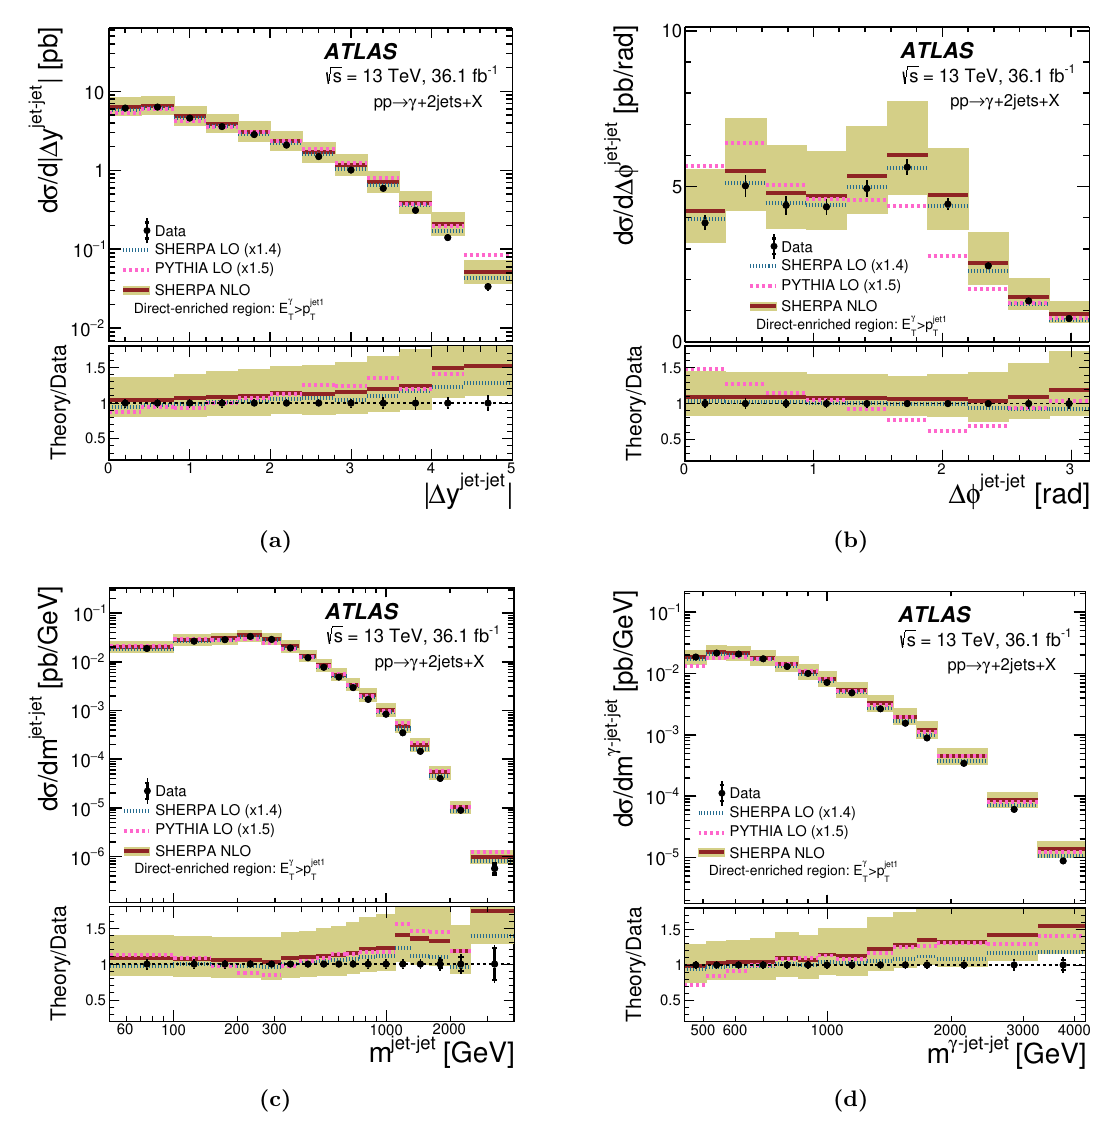
Figure 9 . Measured cross sections for isolated-photon plus two-jet production (dots) as functions of (a) j (cid:1) y jet{jet j , (b) (cid:1) (cid:30) jet{jet , (c) m jet{jet and (d) m (cid:13) {jet{jet for the direct-enriched phase space. The NLO QCD predictions from Sherpa (solid lines) based on the NNPDF3.0 PDFs are also shown. The tree-level plus parton-shower predictions from LO Sherpa (dotted lines) and Pythia (dashed lines) normalised to the integrated measured cross section (using the factors indicated in parentheses) are also shown. The bottom part of each (cid:12)gure shows the ratio of the predictions to the measured cross section. The inner (outer) error bars represent the statistical uncertainties (the statistical and systematic uncertainties added in quadrature) and the (cid:12)lled bands represent the theoretical uncertainty of the NLO QCD predictions. For most of the points, the inner and outer error bars are smaller than the marker size and, thus, not visible. The visible thin error bars represent the outer error